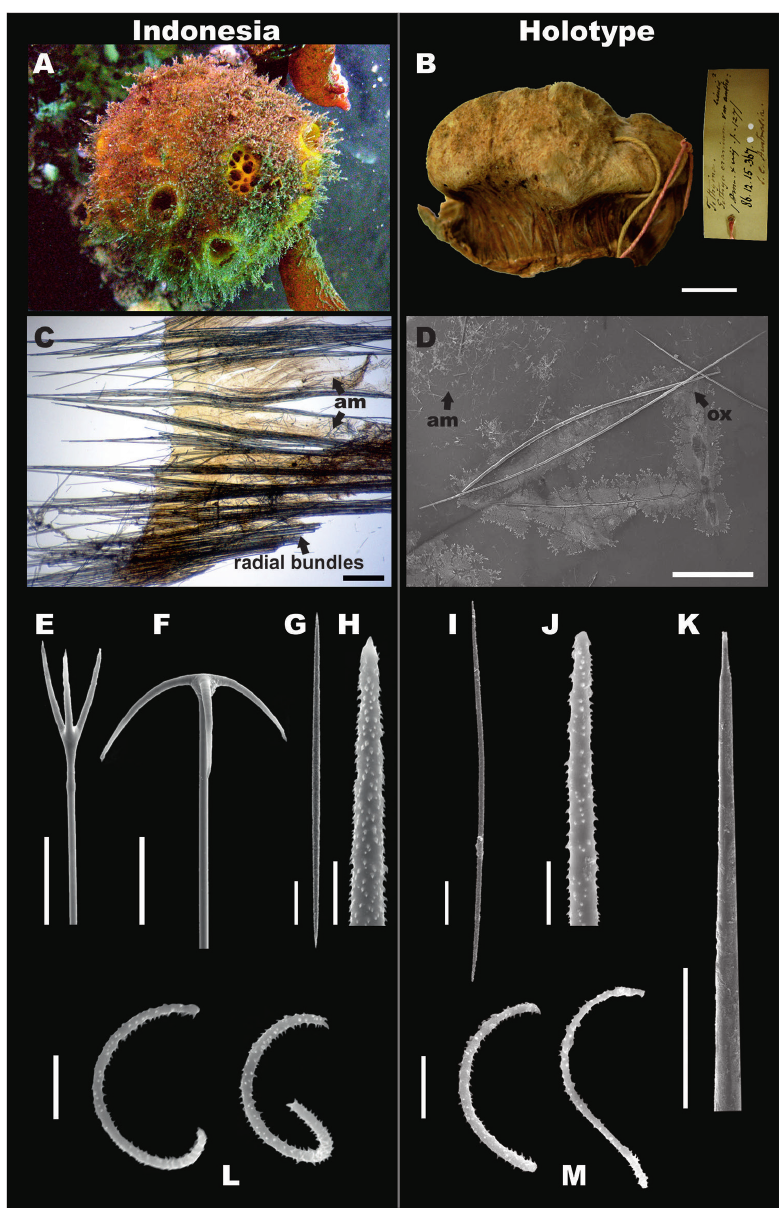
Figure 6. Cinachyrella australiensis . A, C, E-H, L RMNH.POR.11139, Kakaban lake, Indonesia (left side) B, D, I-K, M holotype NHMUK 1886.12.15.367, Port Phillip Heads, Australia (right side) A In situ photograph showing porocalices B dry specimen, lateral view C skeleton showing acanthose microx- eas ( am ) and radial bundles with oxeas D spicule montage showing acanthose microxeas ( am ), and oxeas ( ox ) E protriaene F anatriaene G Acanthose microxea, full lenght H acanthose microxea, detail I acan- those microxea, full length J acanthose microxea, detail K oxea, end detail L, M sigmaspires. Scale bars: 1 cm( B ); 500 µm ( C, D ); 20 µm ( E–G, I ); 5 µm ( H, J, L, M ); 50 µm ( K